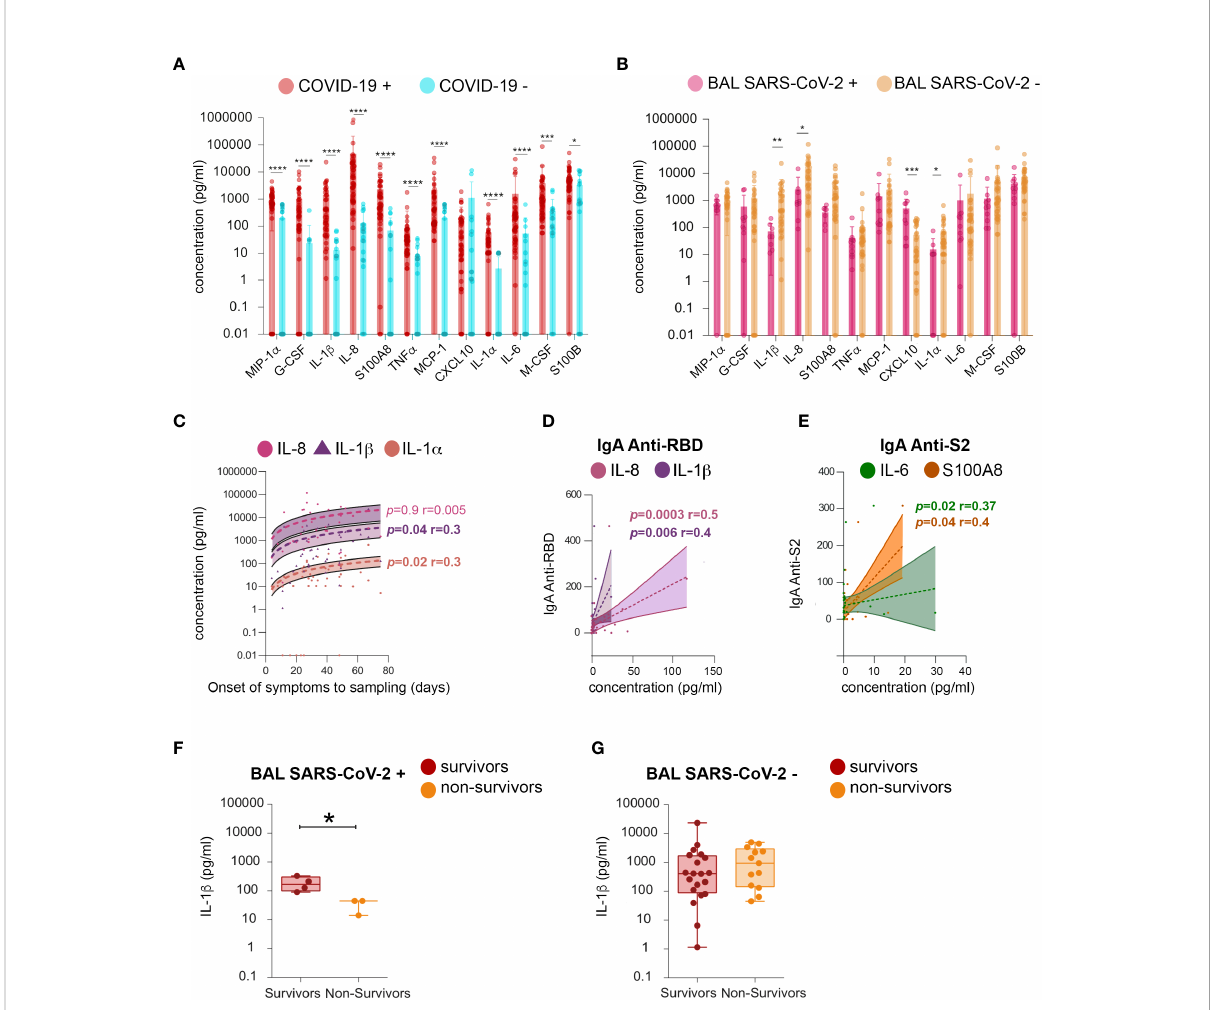
FIGURE 9 Analysis of cytokines in BAL fl uid. Quanti fi cation of the following cytokines in BAL from SARS-CoV-2-infected individuals: MIP-1 a , G-CSF, IL-1 b (IL-1 b ), IL-8, S100A8, TNF-a, MCP-1, CXCL10, IL-1 a (IL-1A), IL-6, M-CSF, and S100B. (A) Mean amounts of cytokines (pg/ml) evaluated between COVID-19+ and COVID-19 − individuals. (B) Mean amounts of cytokines (pg/ml) evaluated between BAL SARS CoV-2+ and BAL SARS CoV-2 − individuals. (C) Cross-sectional concentration (pg/ml) of IL-8, IL-1 b , and IL-1A as function of time from onset of symptoms to sampling date. (D) Correlation between RBD-speci fi c IgA (shown as proportion of speci fi c IgG or IgA over total IgG or IgA measured by ELISA (speci fi c (OD450)/total IgA or G ( m g/ml)) and IL-1 b and IL-8 concentration (pg/ml). (E) Correlation between S2-speci fi c IgA (shown as proportion of speci fi c IgG or IgA over total IgG or IgA measured by ELISA (speci fi c (OD450)/total IgA or G ( m g/ml)) and S100A8 and IL-6 concentration. (F) Comparison of the levels of IL-1 b (pg/ml) between survivors and non-survivors in SARS-CoV-2+ BAL individuals. (G) Comparison of the levels of IL-1 b (pg/ml) between survivors and non-survivors in individuals BAL SARS-CoV-2 − . p -Values were calculated by using Mann – Whitney test. *, p < 0.05, **, p < 0.01; ***, p < 0.005, ****, p < 0.0001. BAL, bronchoalveolar lavage; G-CSF, granulocyte colony-stimulating factor; RBD, receptor-binding